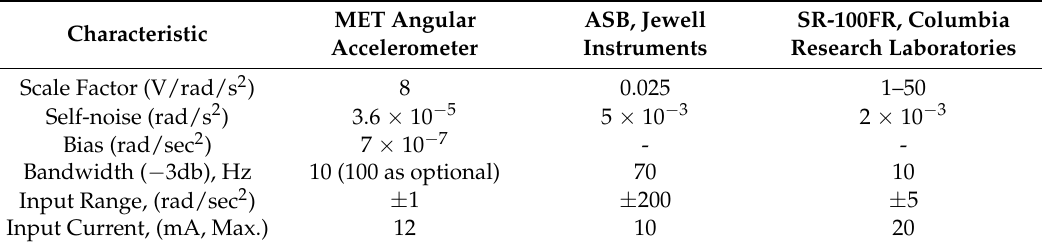
Table 1. Comparison of the obtained main characteristics with the analogues.